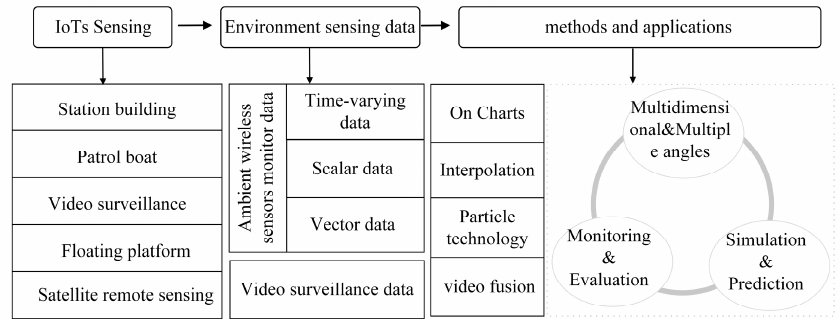
Figure 1. Visualization framework of environmental sensing data in DT world of lakes.